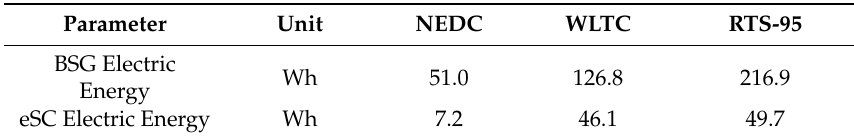
Table 9. Electrical energy required by the BSG (Torque-Assist) and by the eSC on the NEDC, WLTC and RTS-95.